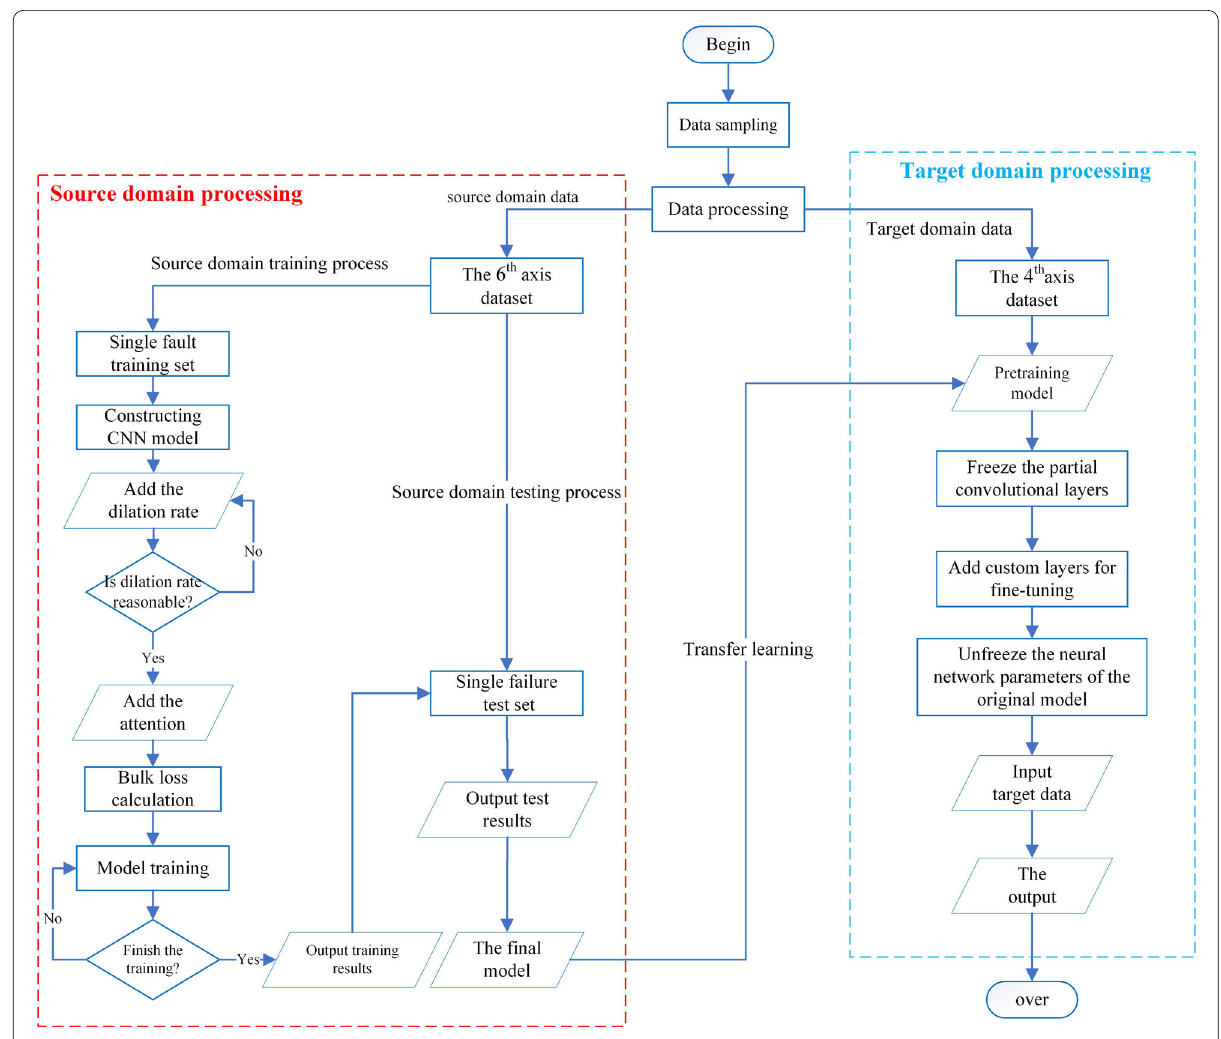
Figure 1 The general flow chart of fault diagnosis based on transfer